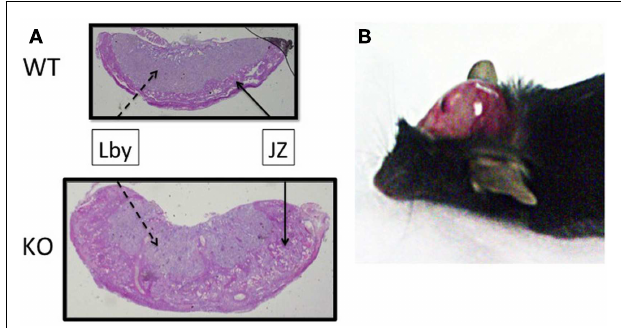
FIGURE 2 | Effect of Plac1 ablation on placental and brain development . (A) H&E stain of E16.5 mouse placentae associated with KO andWT males. JZ, junctional zone; Lby, labyrinth. (B) Postmortem, 6-week-old X m − X Het female with hydrocephalus.The cranium was retracted to expose the brain